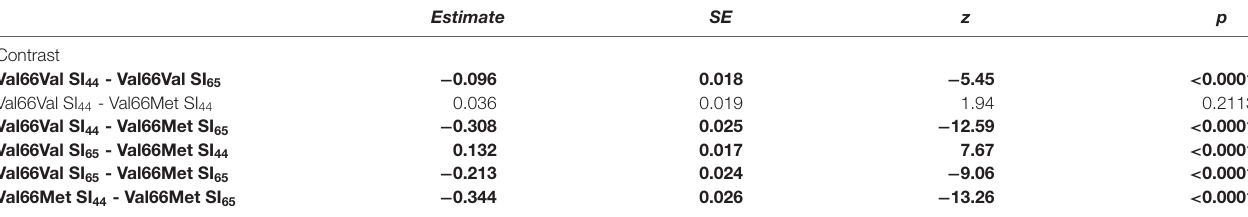
TABLE 5 | Post hoc comparison results assessing the difference in MEPs across the time points for Val66Val vs. Val66Met BDNF genotypes at the median of the upper (SI 65 ) and lower (SI 44 ) tercile of the range of SI